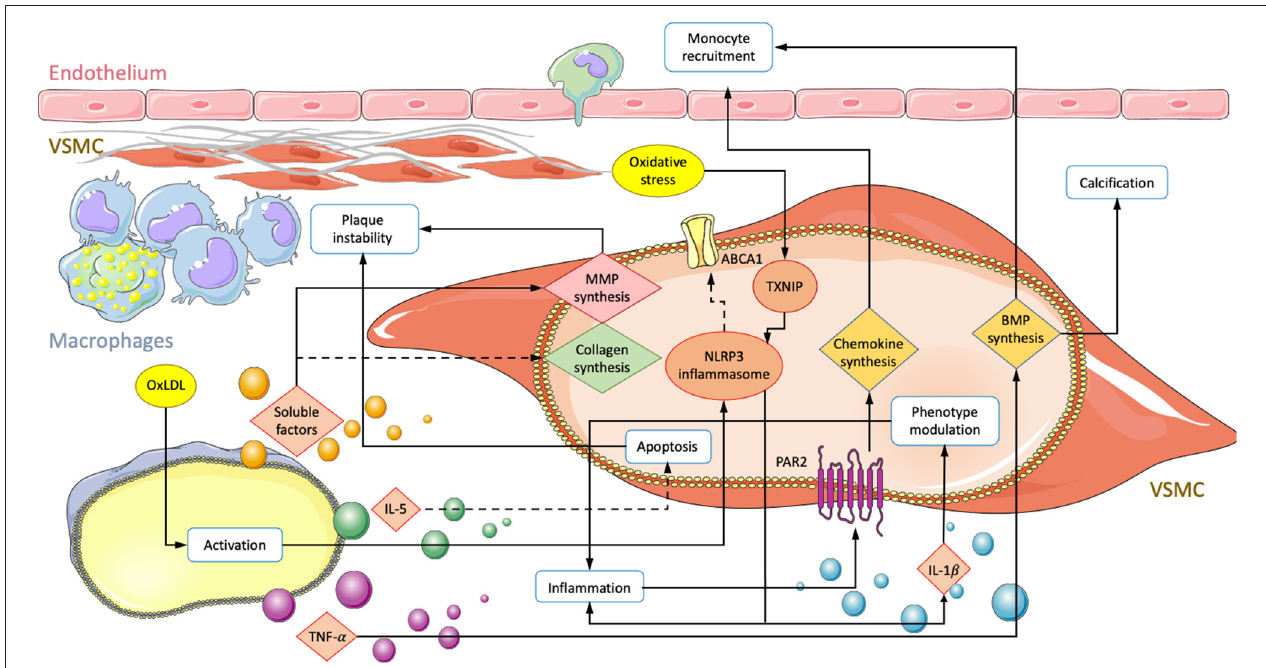
FIGURE 1 | Summary of interactions involving an exchange of soluble factors between macrophages and VSMCs in atherosclerosis. Depiction of a vessel with an endothelial layer on the top and fibrous cap producing VSMCs lying underneath. Macrophage secretion of unestablished soluble factors, TNF- α , IL-5, and oxLDL mediated activation lead to transcriptional changes in VSMC. Solid arrows correspond to enhanced activity and dotted lines represent down regulated processes. Modifications result in increased monocyte recruitment, plaque instability, subendothelial calcification, and